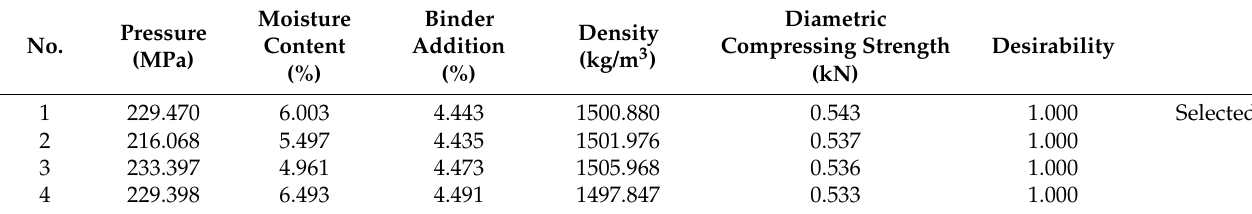
Table 7. Optimization